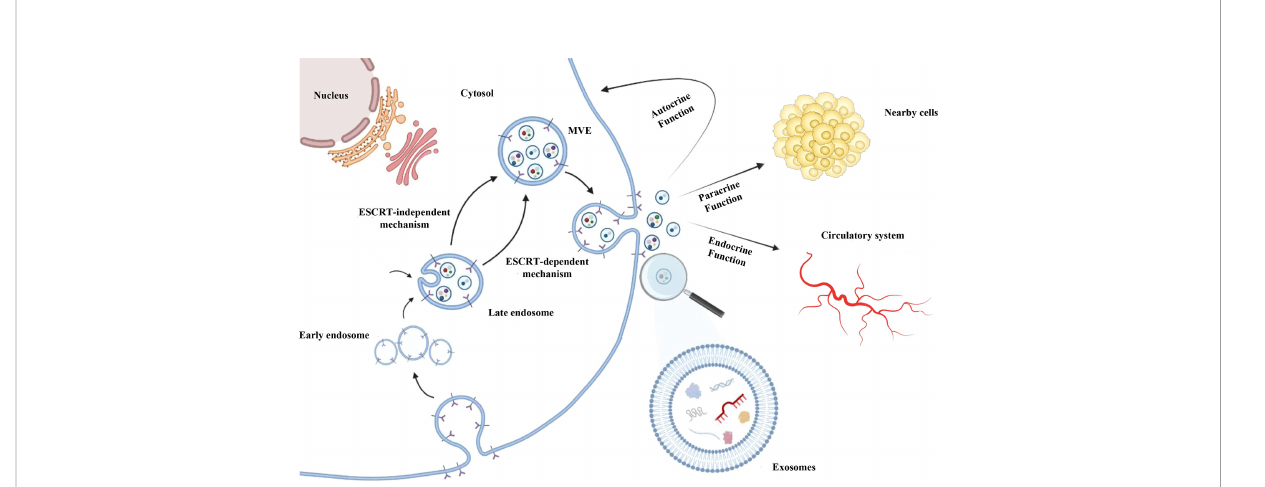
FIGURE 1 Exosomes biogenesis. After being generated by endocytosis at the level of endosomal system, exosomes are included as invagination within the multivesicular endosomes (MVEs) lumen and released as an outward budding upon the fusion of MVEs with the cell membrane. MVEs formation can occur mainly by endosomal sorting complex required for transport (ESCRT) pathway-dependent mechanism; ESCRT-independent mechanisms were also described. Exosomes can contain different cargos, such as proteins, lipids, DNA, mRNAs, lnRNAs and miRNAs. Exosomes are uptake by recipient cells thus favouring intercellular communication through their autocrine, paracrine and/or endocrine